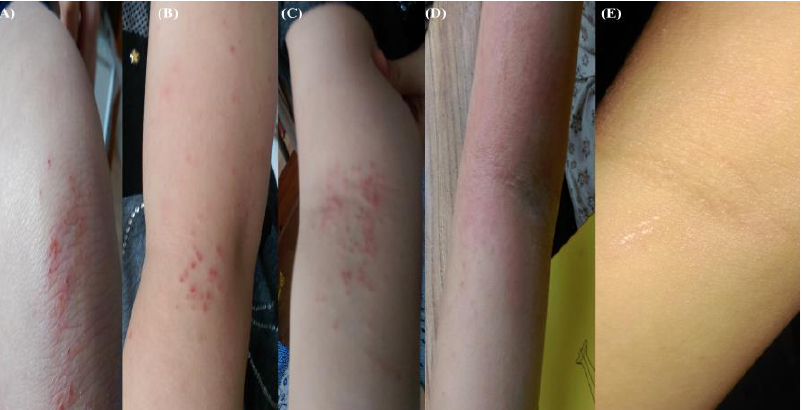
Figure 3. Suspected stress-induced flare without infection. Photograph (10 October 2017) of grazed knee, healing time 10 days ( A ). Photograph (11 October 2017): flaring, outer right ( B ) and inner left forearms ( C ). Photograph (26 October 2017): severe inflammation, Fucidin and mupirocin treatments discontinued, bacterial and fungal ( Candida and Malassezia ) involvement suspected ( D ). Resolution of AD symptoms following daily disinfection (1% Chloroxylenol spraying) of bedding covers ( E